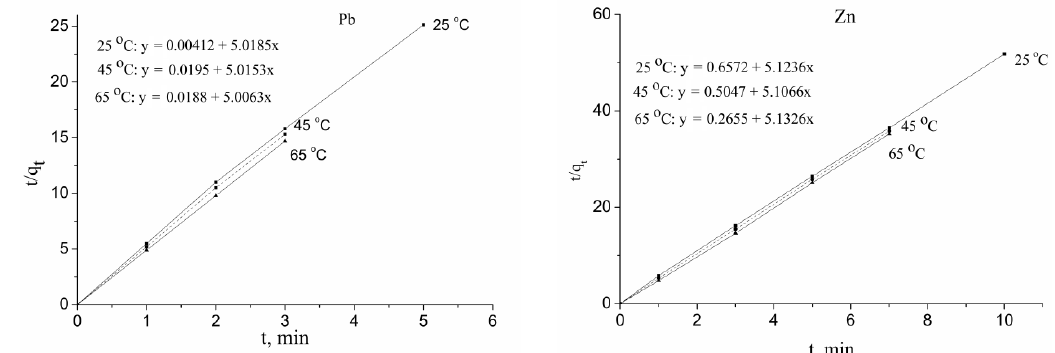
Figure A1. Pseudo-second-order kinetics for Pb 2+ and Zn 2+ ion adsorption on titanium phosphate (the initial concentration of metal ions was 1 mmol·L −1 ).